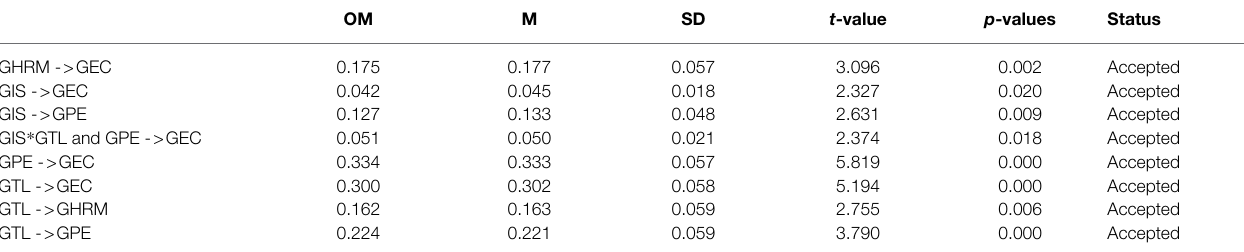
TABLE 7 | Direct effects.